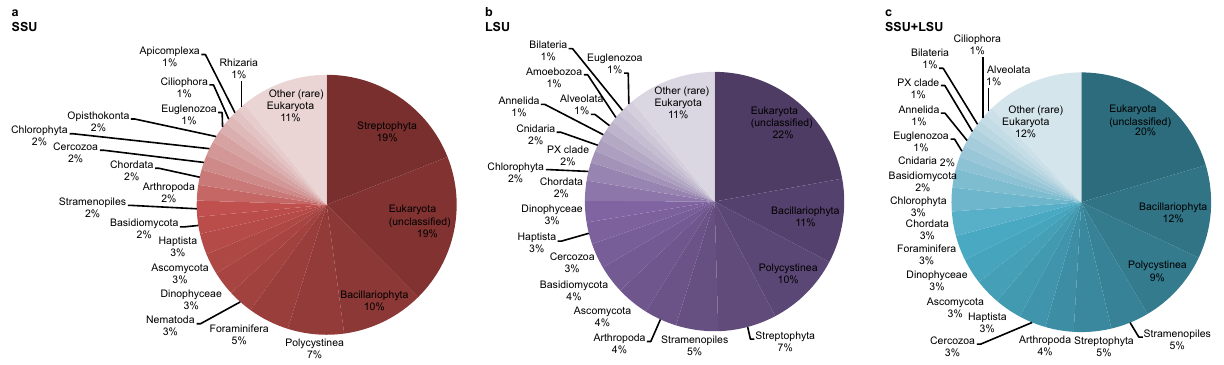
Fig. 2 | Relative eukaryote abundance across all samples using SSU, LSU and SSU+LSU reference databases. Pie charts were generated based on relative abundances (phylum level) determined after running shotgun data against the